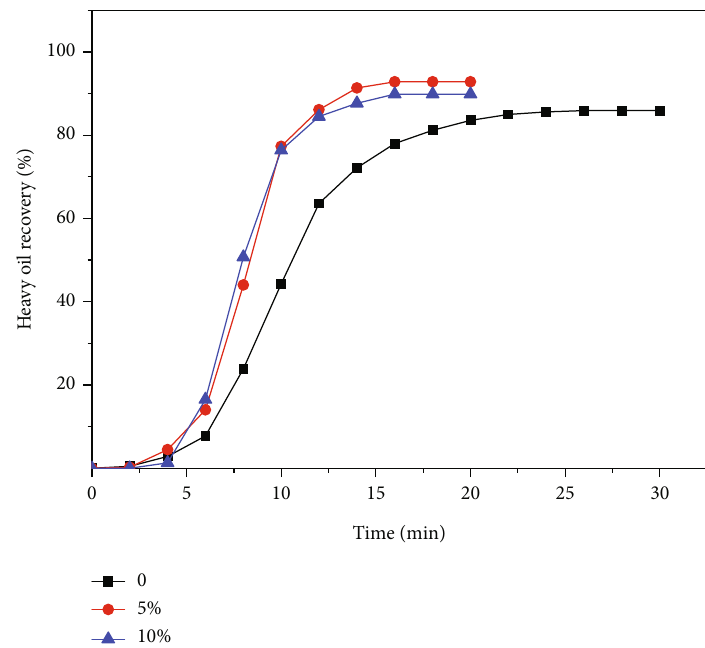
Figure 10: The experimental heavy oil recovery curves of each group under di ff erent water content.